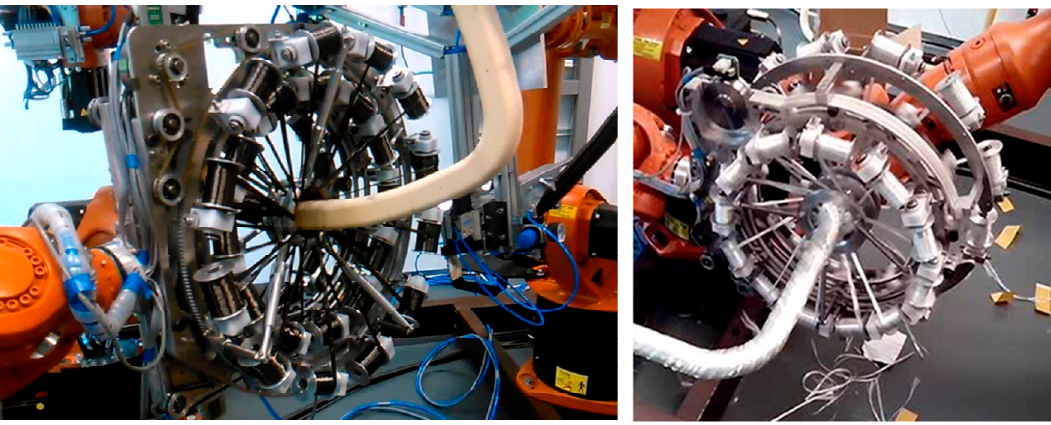
Figure 6. Different views of robot KR 16-2 with non-bearing core frame and fiber-processing head with three guide lines.